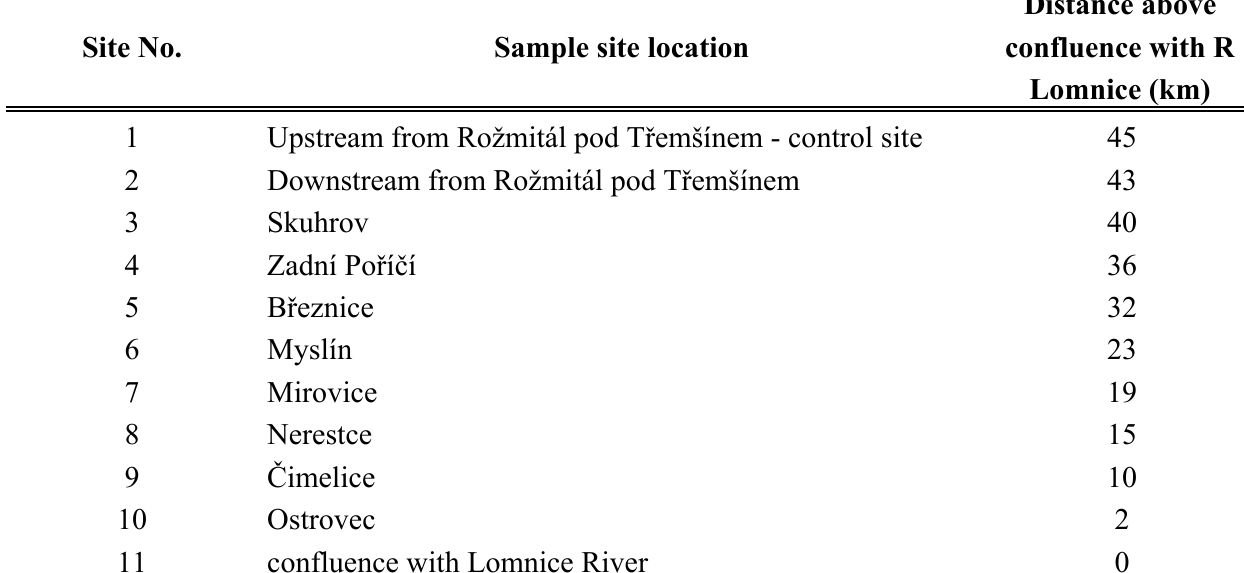
Table 1. Sample sites on the River